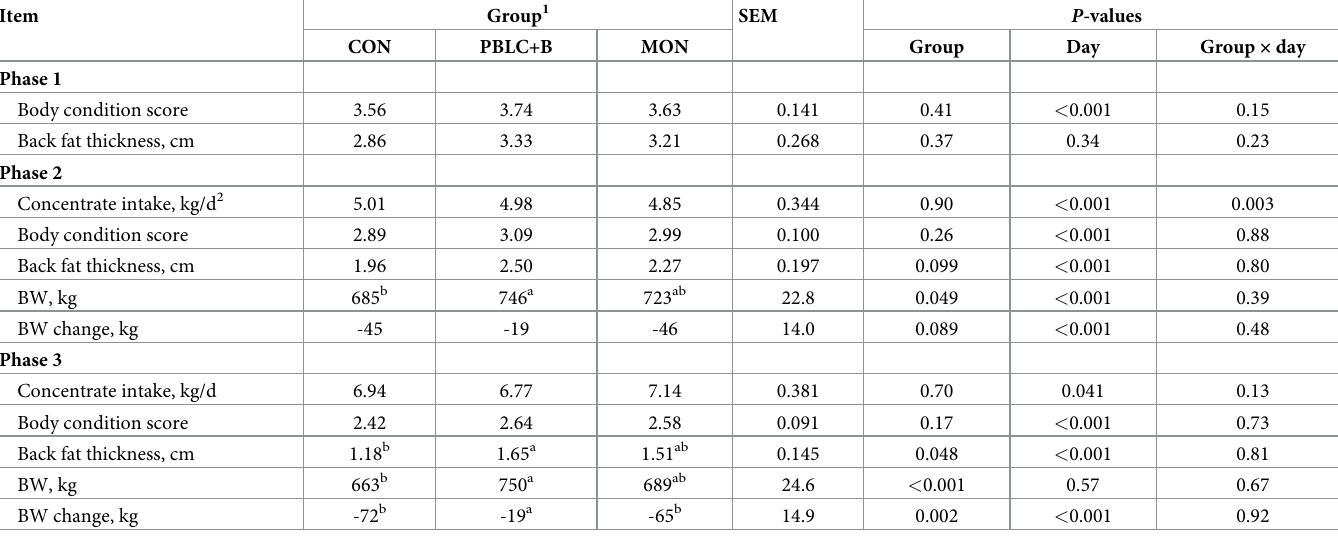
Table 2. Concentrate intake, body weight (BW), BW changes, body condition score and back fat thickness of cows receiving plant bioactive lipid compounds and biotin (PBLC+B; n = 18) from d -21 to 37 relative to parturition, cows receiving a monensin bolus (MON; n = 18) at d -21 or cows receiving no such supplements (CON; n = 17).